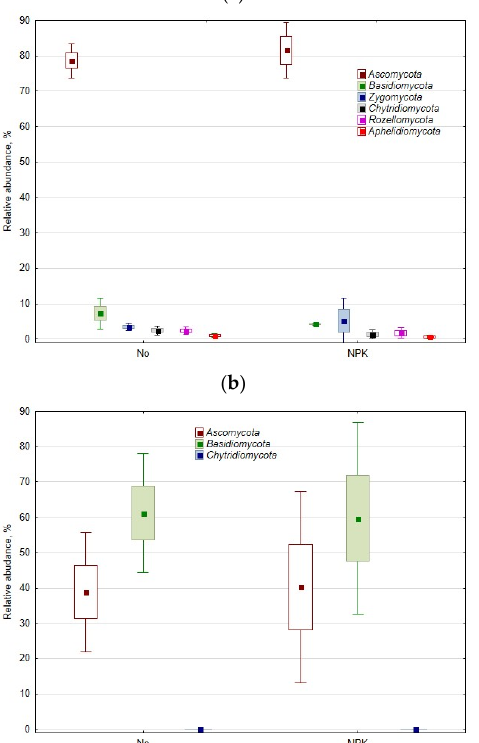
Figure 2. The relative abundance of fungal phyla in the rhizosphere (only dominants ( a )) and roots (all phyla ( b )) of tomato plants grown under different fertilization on Phaeozem in the open field in the south of West Siberia. Squares denote means, boxes denote standard errors, and whiskers denote standard deviations. A taxon was considered dominant if its relative abundance was ≥ 1.0%. 3.2.2. The Effect of Mineral Fertilization on the Rhizosphere and Root Mycobiome